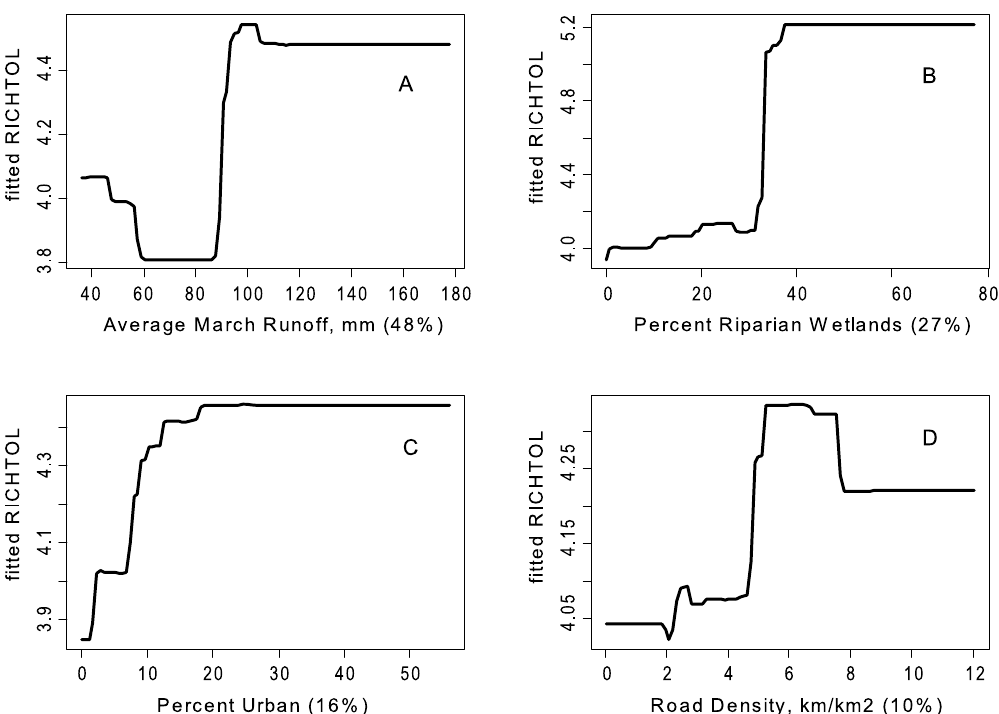
Figure 5. Partial dependency plots for variables in BRT model for RichTOL for NE Highlands Region. Boosted regression tree partial dependency plots show the response form of average taxa tolerance (y-axis = fitted function of RichTOL) based on the effect of individual explanatory variables with the response of all other variables removed (development data set). Shown in order of model importance: (A) average March runoff (mm), (B) percent riparian wetlands, (C) percent urban and (D) road density (km/km 2 ), model R 2 =0.80. The relative contribution of each explanatory variable is reported in parentheses. Refer to Table 1 for variable definitions. All four explanatory variables modeled can be interpreted as an urbanization land use effect. Average March is expected to increase due to higher imperviousness with higher urbanization and percent riparian wetlands we believe is acting as a surrogate for urbanization; higher wetlands commonly occur in lower elevation valleys where there is commonly more urban development. The last two variables measure urban land use